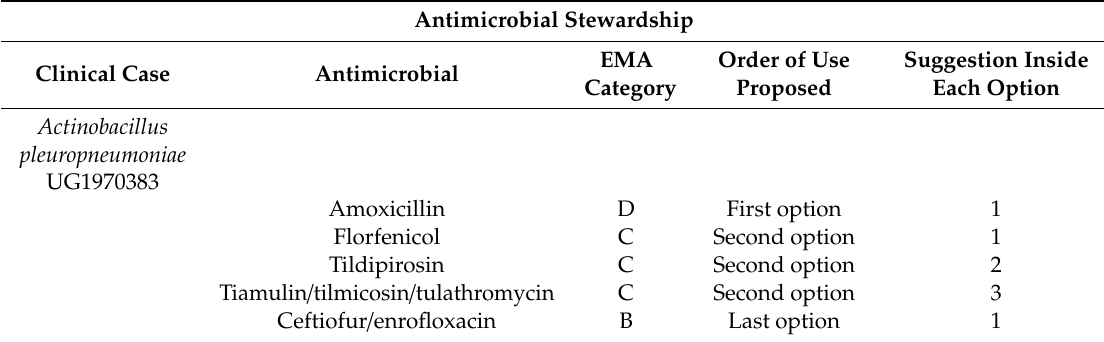
Figure 4. Antimicrobial susceptibility pattern and a pharmacological recommendation based on MIC results, clinical breakpoints available [15], and EMA categorization of antimicrobials [6] are detailed for case of report 2. It is included the current case and three former APP cases coming from the same sow origin. More information is available in Supplementary Material S1. Table 4. Antimicrobial stewardship for an Actinobacillus pleuropneumoniae strain isolated in a clinical case with reference report 2.